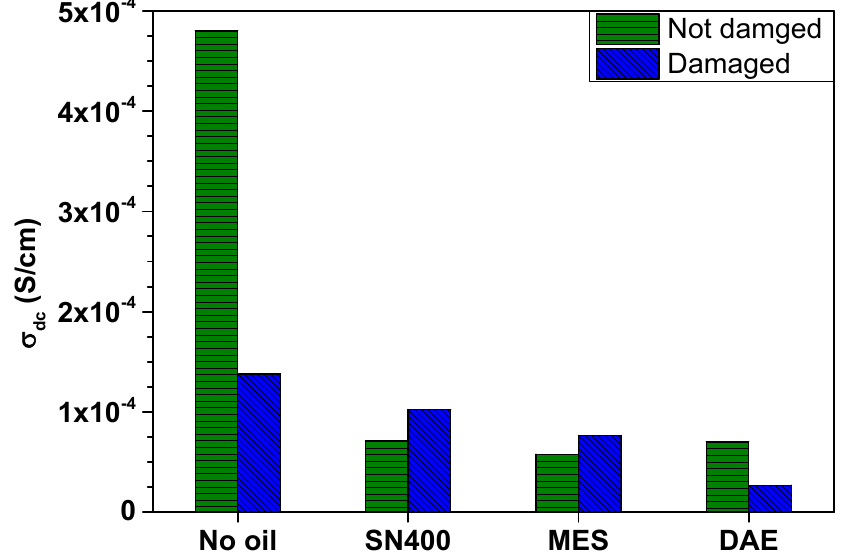
Figure 5. Difference in DC conductivity σ dc between the mechanically not damaged (without static load) and damaged (static force of 10 N) SBR samples.